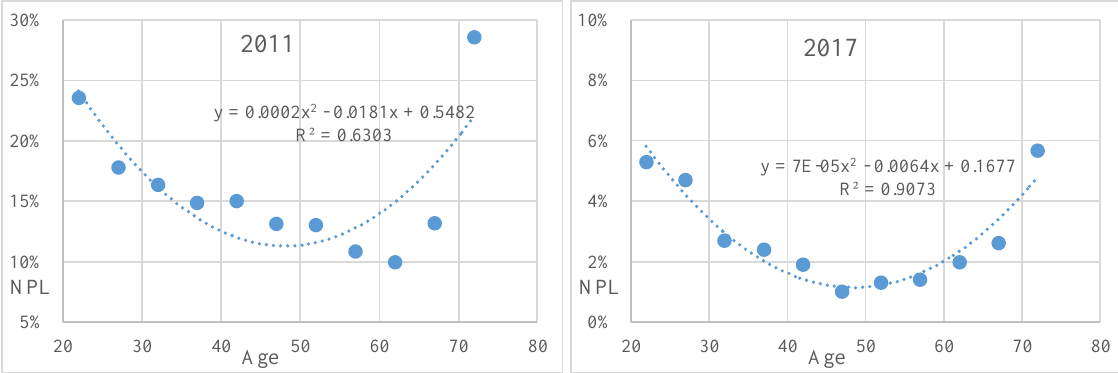
Figure 4. Borrowers age and NPL’s distributions.